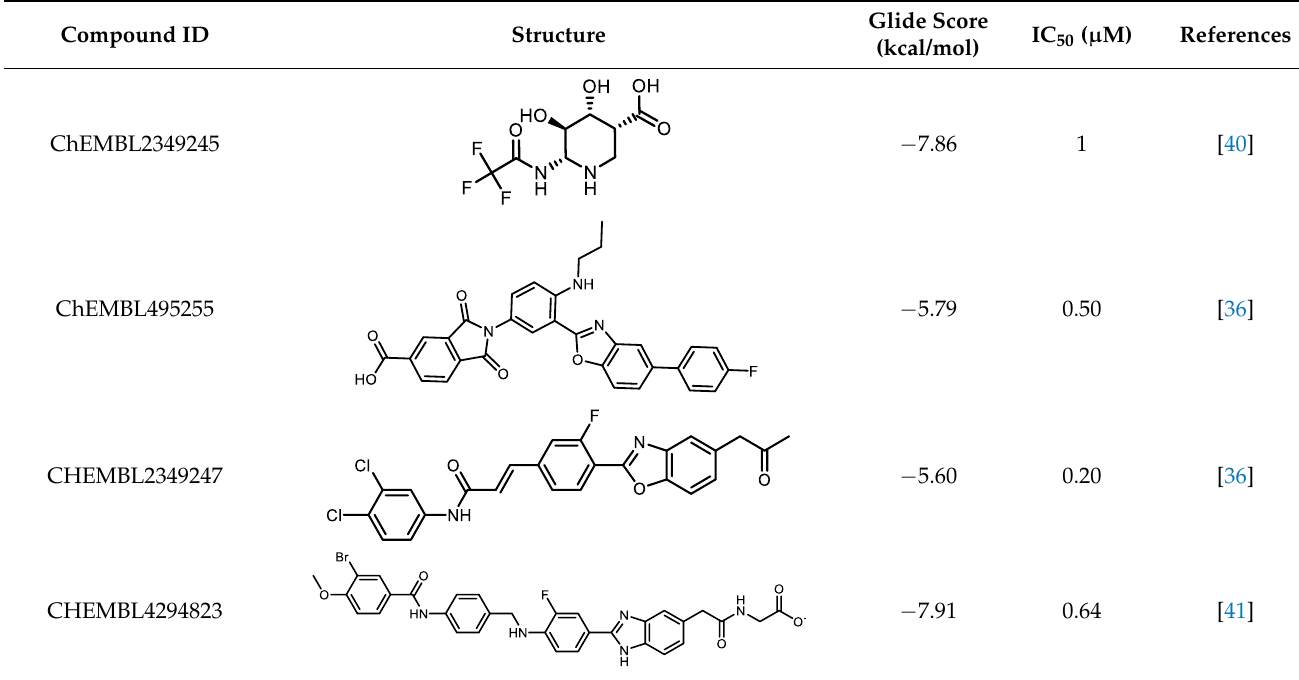
Table 1. Structure, IC 50 and docking scores of the selected HPSE inhibitors ChEMBL2349245,